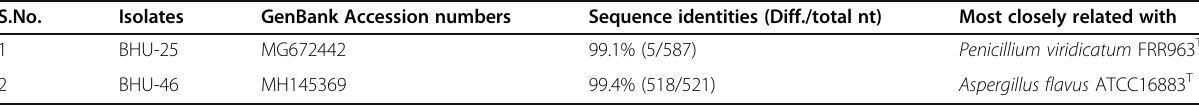
Table 3 Genbank accession number of promising isolates